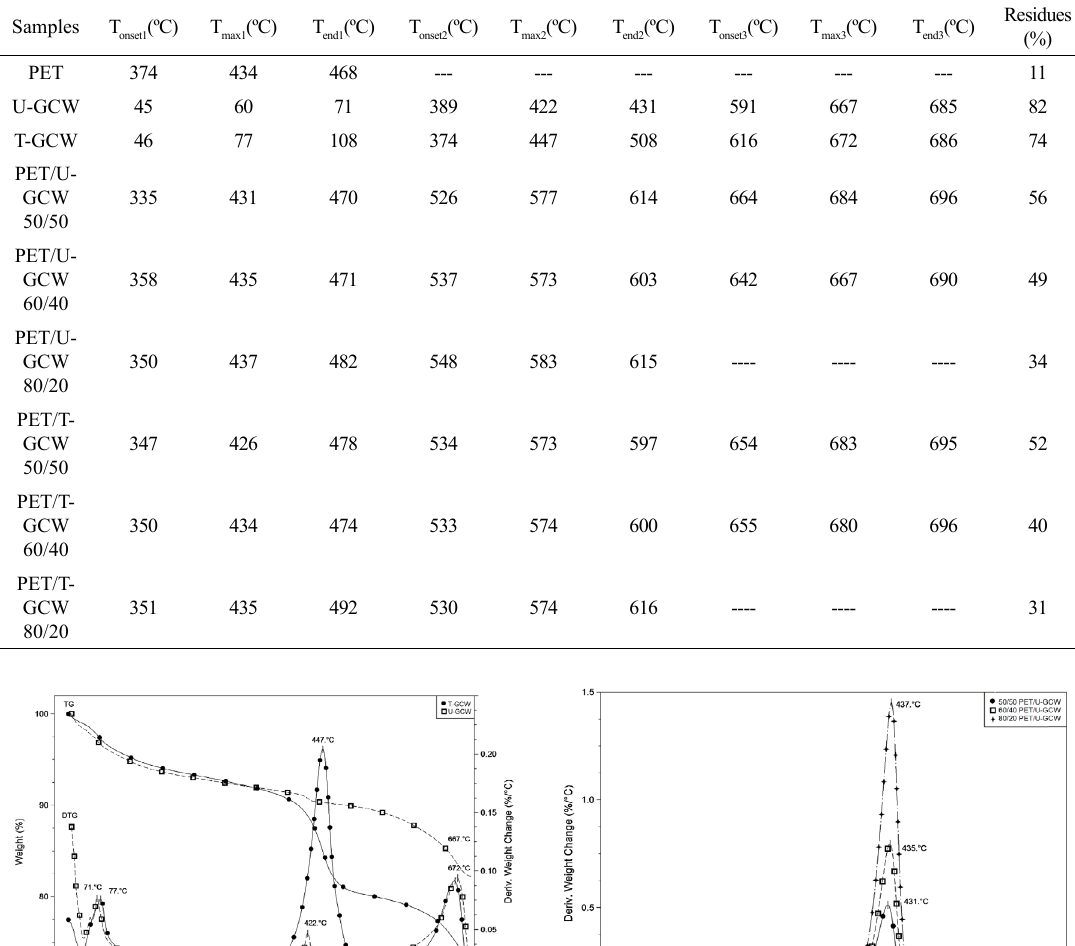
Table 5. TG/DTG properties of the specimens.